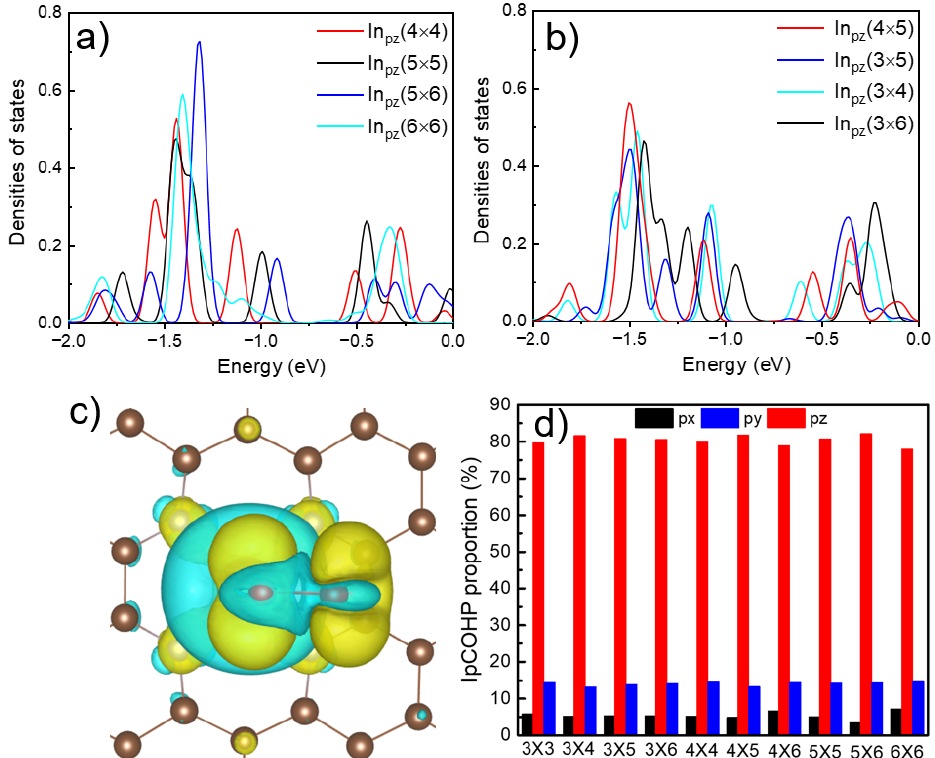
Figure 3. ( a , b ) The p z orbital PDOS of InN 4 is distributed in different unit cells. ( a ) several InN 4 material with decent 2e − ORR activity; ( b ) The PDOS distribution of the p z orbital of less active InN 4 ; ( c ) The difference charge distribution of the surface of InN 4 (4 × 4) with adsorbing OOH. Yellow is the electron accumulation area and cyan is the electron deficient area; ( d ) The integral of the partial Crystal Orbital Hamilton Population (IpCOHP) proportion distribution between In atoms and O (OOH) atoms on the surface of InN 4 .